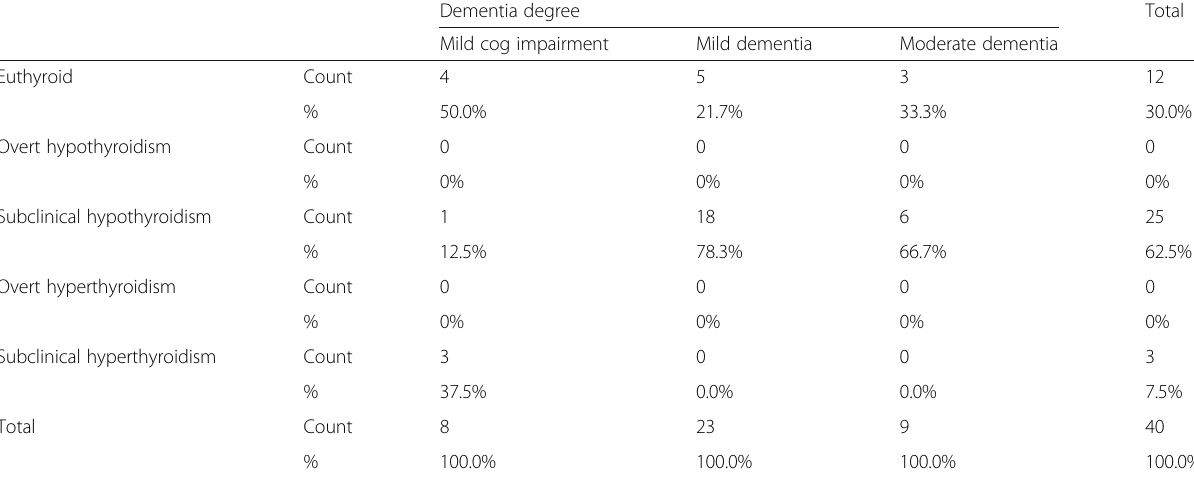
Table 9 Relation between the degree of dementia and thyroid dysfunction